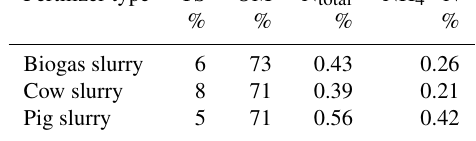
TS: total solids. OM: organic matter. Nutrient contents determined in the laboratory in 2015 and 2016 for Kraichgau and 2014, 2015 and 2016 for research site EC6 (SA). Otherwise, average values were assumed based on expert knowledge, as given